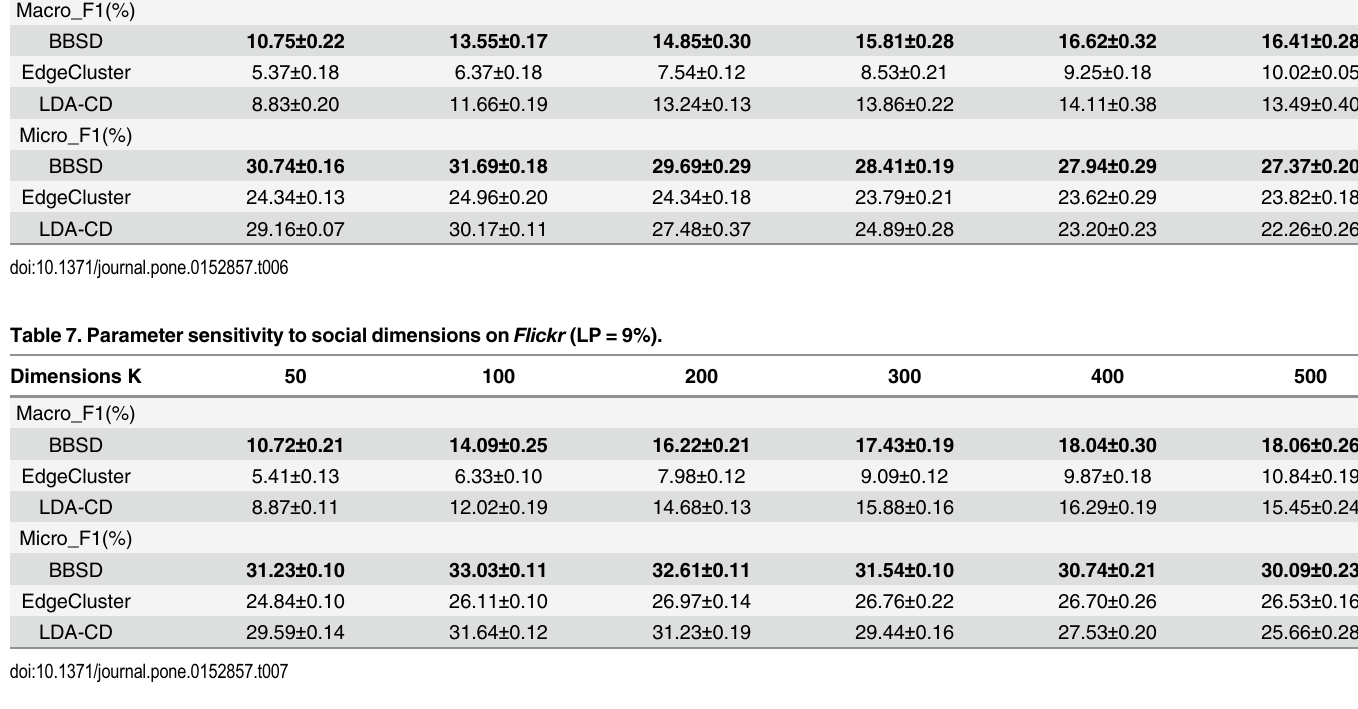
Table 6. Parameter sensitivity to social dimensions on Flickr (LP = 5%). Dimensions K